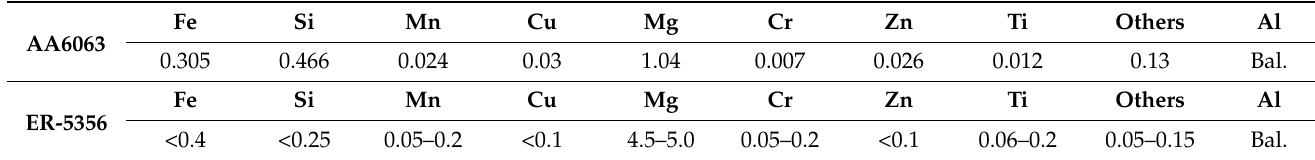
Figure 2. Schematic illustration of ( a ) cycle time, feed time and delay time; ( b ) bead width measure- ment, thermocouple arrangement; and ( c ) cross-section weld metal area. Table 2. Chemical composition of AA6063 and filler ER-5356 (wt